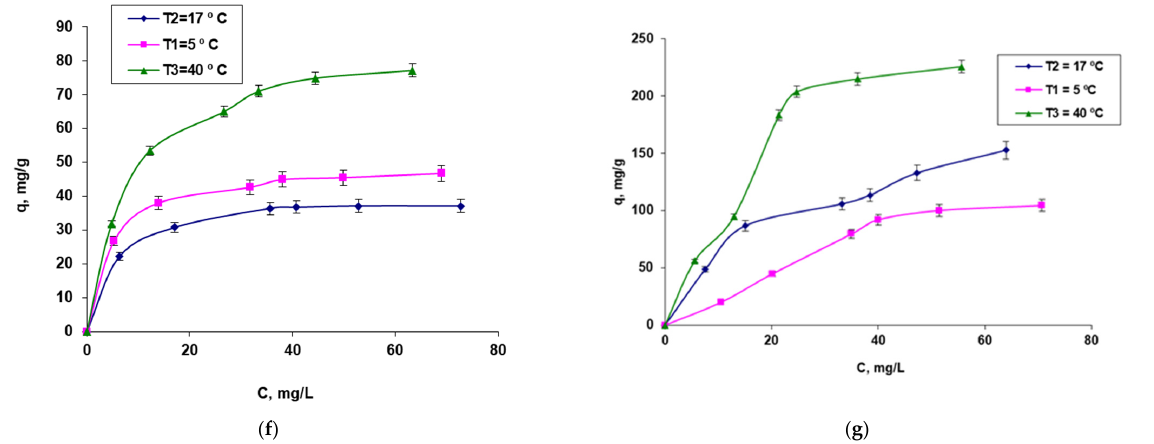
Figure 4. Factors influencing the biosorption of the cationic dye methylene blue dye onto microbial biosorbent obtained by a simple dripping technique ( a , c , f ) and by encapsulation using a Buchi microencapsulator ( b , d , g ); ( a , b ) the influence of pH and biosorbent production technique; ( c , d ) the influence of biosorbent dose and biosorbent production technique; ( e ) the influence of contact time between phases; ( f , g ) the influence of temperature and initial concentration of the dye solution.